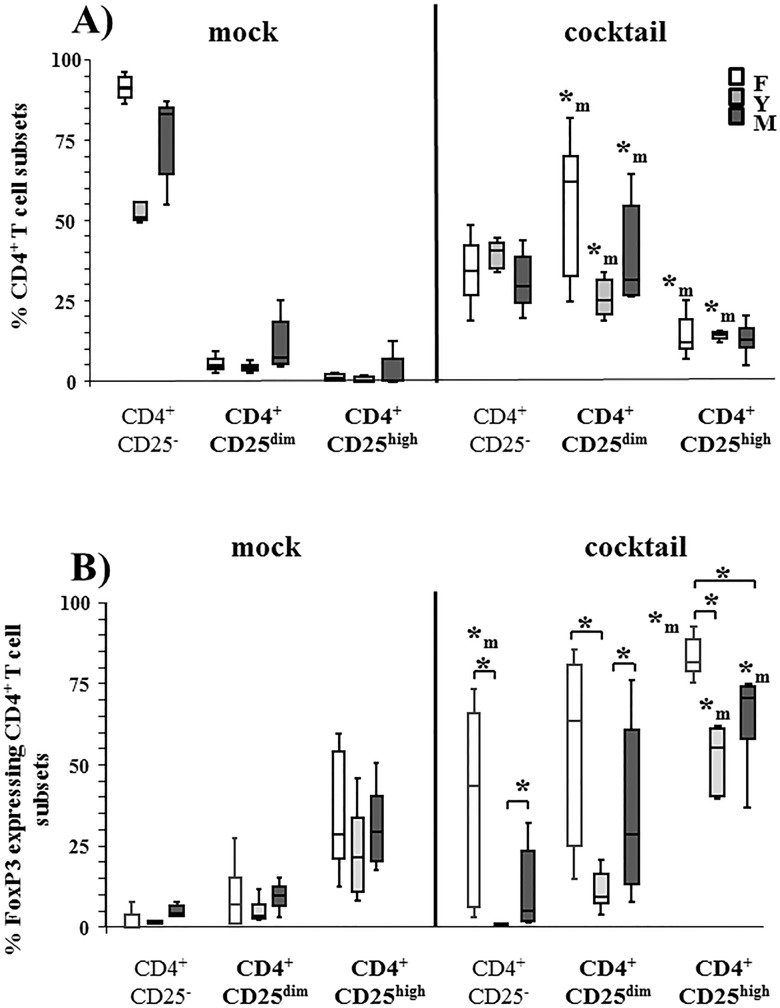
Proportion of CD4+ T cell subpopulations and expression of FoxP3 within these subpopulations following stimulation.4x106 freshly isolated PBMC from foals (F), yearlings (Y) and from mares (M) were left either un-stimulated (mock) or stimulated with a combination of conA, r.IL-2 and r.TGF-β1 (cocktail) for four days. Horses included are the same as mentioned in Fig. 1. Proportion of CD4
+
CD25
−, CD4
+
CD25
dim and CD4
+
CD25
high T cells (A) and expression of FoxP3 (B) within these subpopulations were determined and presented as in Fig. 1. In addition, (*m) indicates a significant difference to mock within the respective cell subpopulation of the same horse group using non-parametric Wilcoxon signed-rank paired t-test.